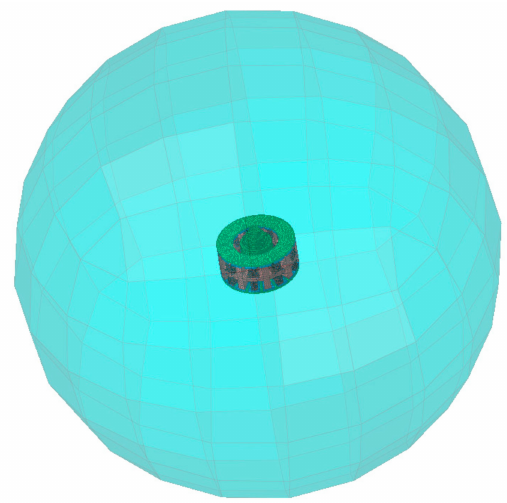
Figure 17. The sphere of microphones used to detect the AFPM motor’s radiated sound.